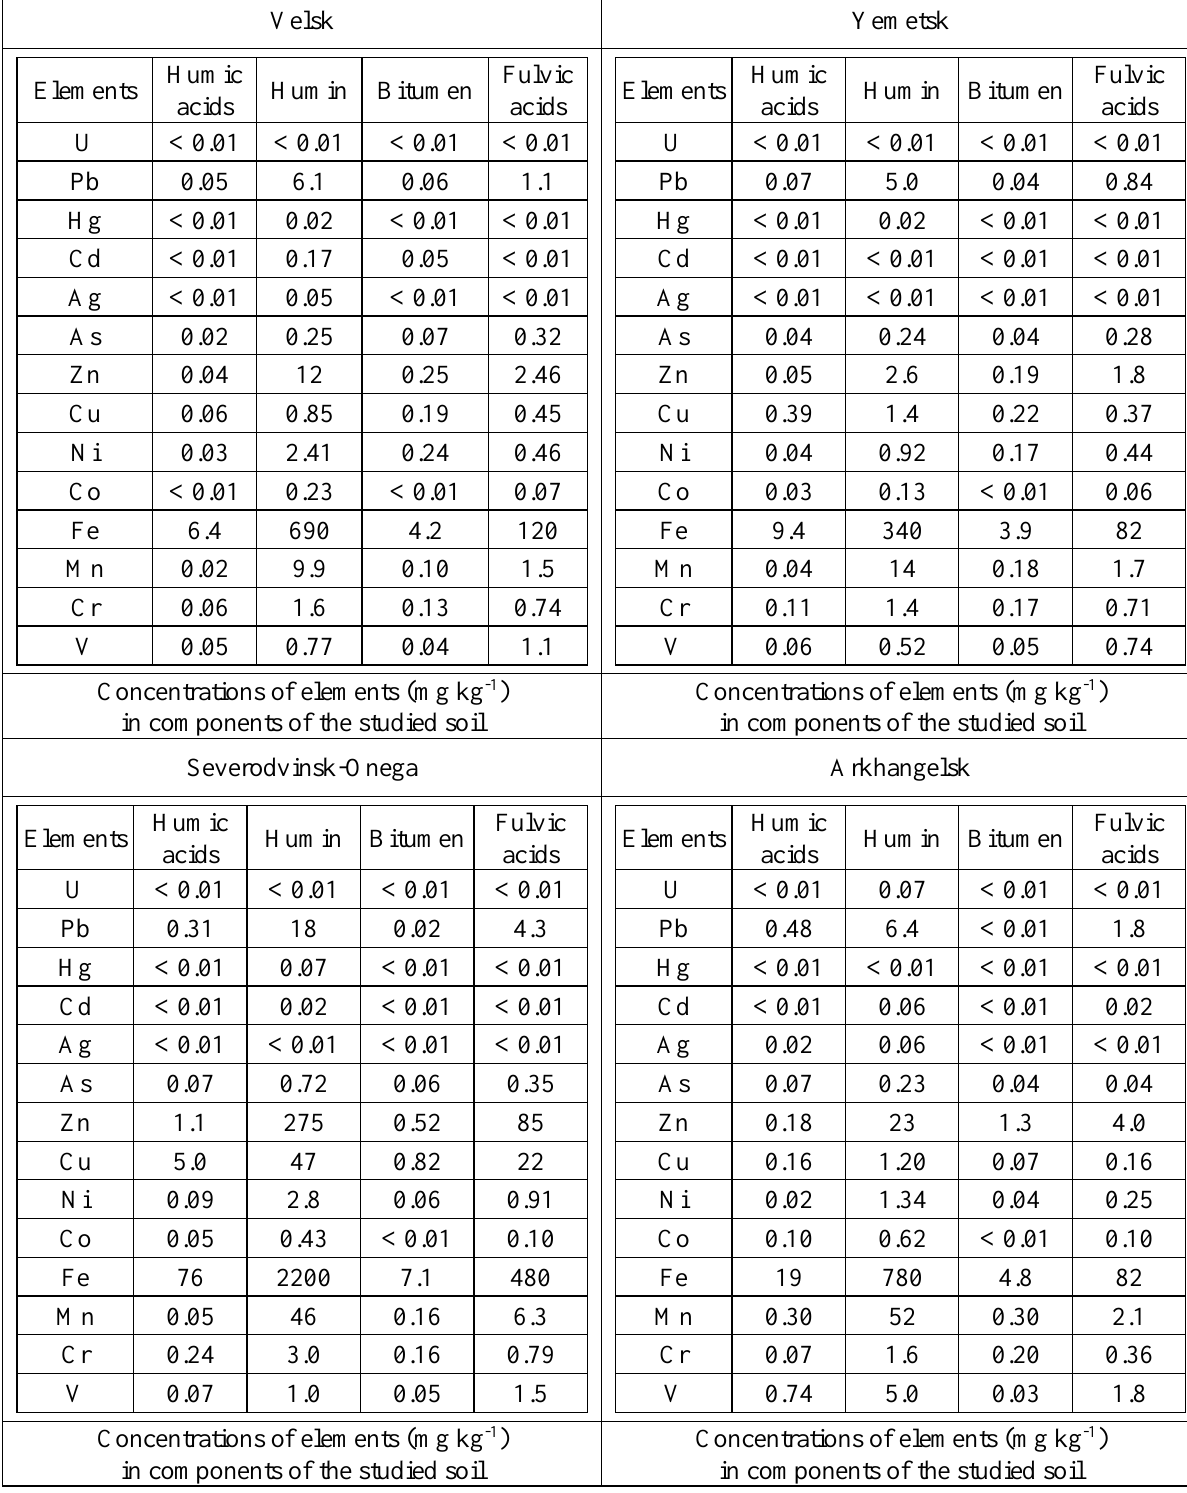
Table A3. The average concentrations of elements (mg kg -1 ) in the components of the peat. Velsk Yemetsk